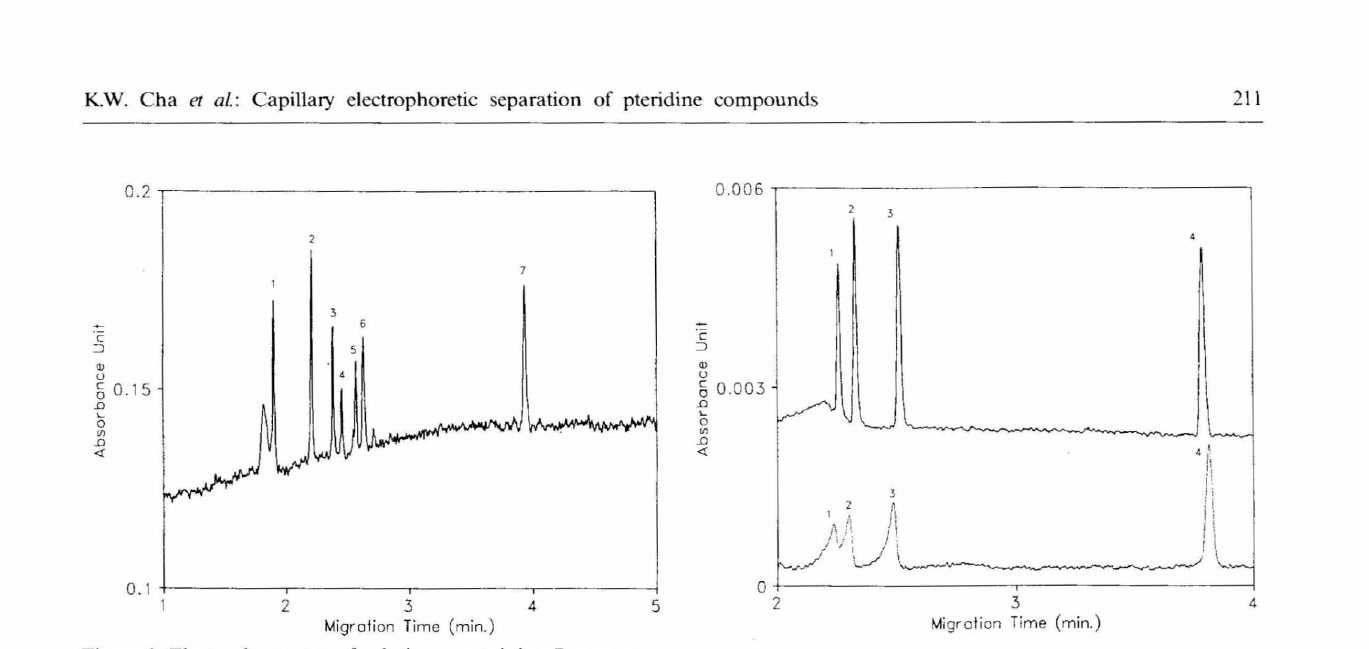
Figure I. E1ectropherogram of solutions containing 7 represen titive pterins. I, sepiapterin; 2, %Iimuspterin% the newly puri fied pterin from Chlorobium limicola; 3, biopterin; 4, neopte rin; 5, pterin; 6, monapterin; 7, ~arboxypterin. Hydrostatic